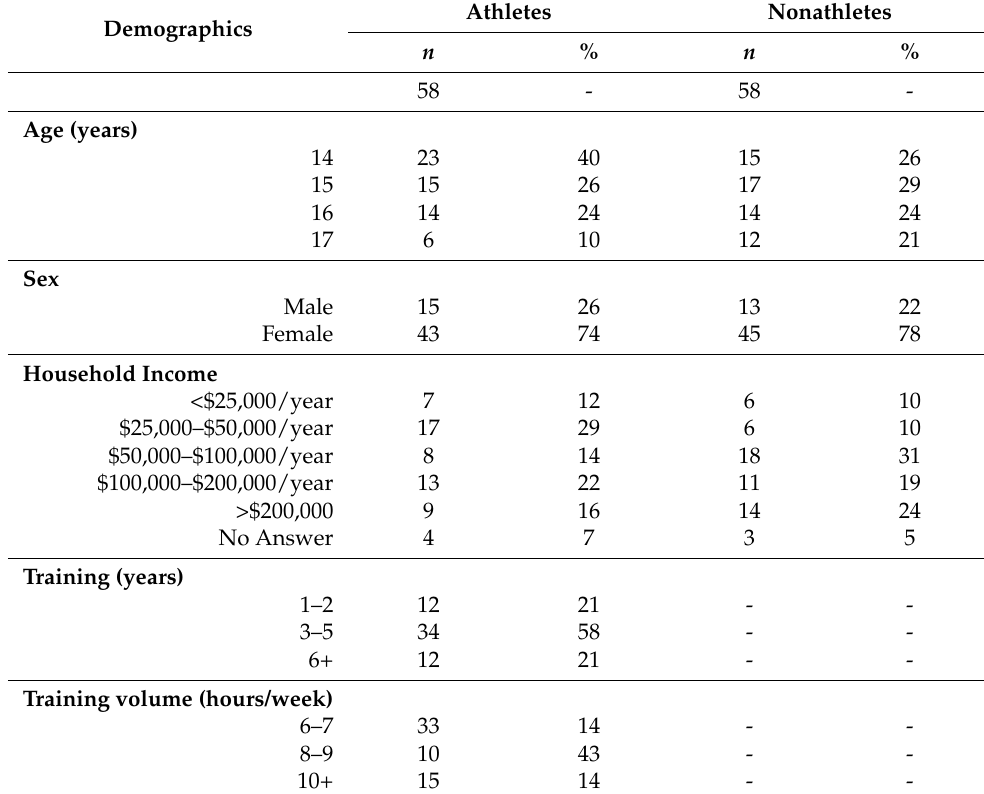
Table 1. Demographic characteristics of